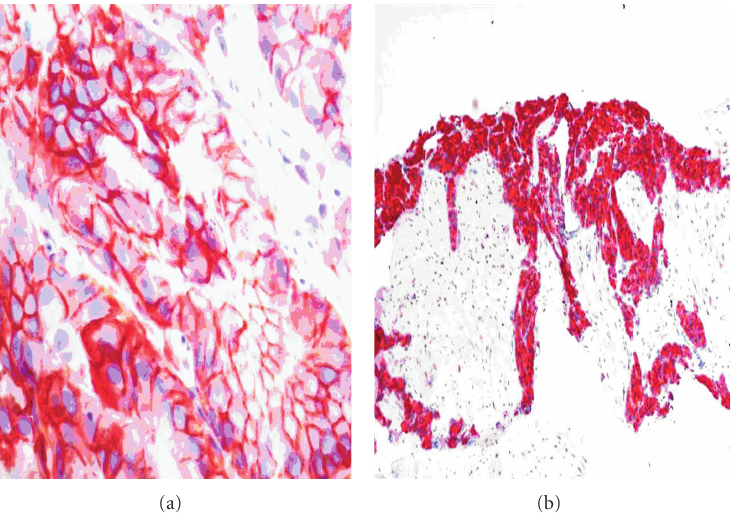
Figure 3: Hormone- and radio-na¨ıve PCa (Gleason 4 + 4 = 8) with strong membraneous HER2/neu expression (Figure 3(a)), indicating that the outlaw pathway is relevant for tumor progression under standard ADT and RT. Local PCa recurrence after salvage radiotherapy (Figure 3(b)). High levels of bcl-2 expression indicate that standard ADT is insu ffi cient for local tumor control. Since docetaxel inhibits the antiapoptotic function of bcl-2, ADT combined with docetaxel may be more successful for local tumor control than standard ADT alone. Original magnifications: (a) ( × 400), (b) ( ×